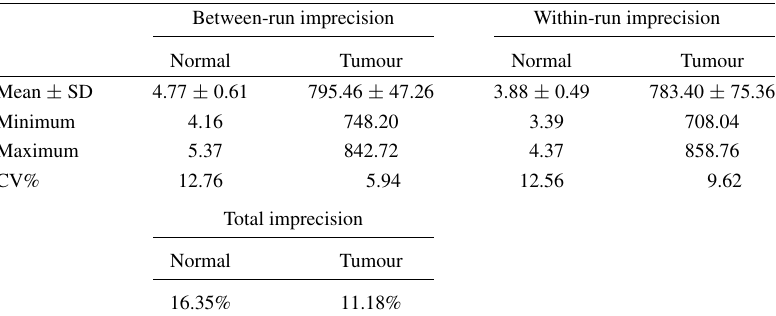
Analytical assessment of imprecision Between-run imprecision Within-run